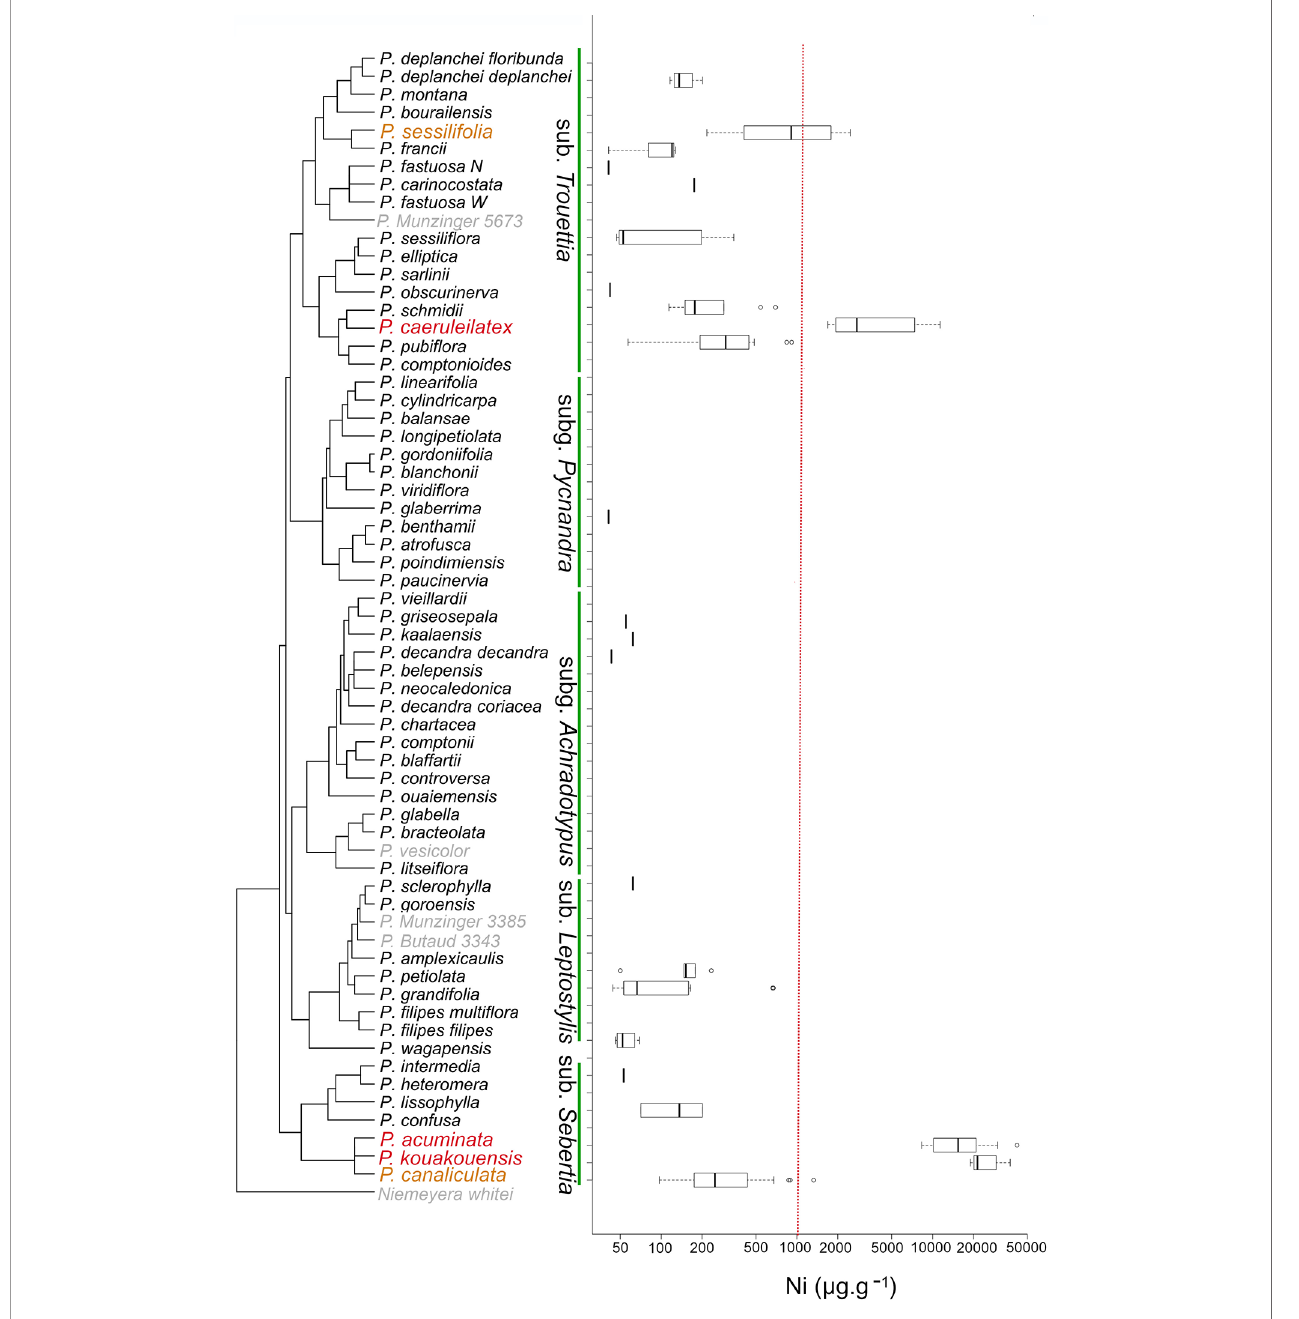
FIGURE 4 | Phylogenetic distribution of hyperaccumulation in the endemic genus Pycnandra (Sapotaceae) from New Caledonia. On the left, phylogenetic tree of Pycnandra , simpli fi ed and adapted from Swenson et al. (Swenson et al., 2007; Swenson et al., 2015), including 57 of the 59 described species, plus 4 undescribed species ( Pycnandra fastuosa W (=open-veined ) , P. Munzinger 3385, P. Butaud 3343, P. Munzinger 5673, see Swenson and Munzinger, 2016 for details). Subgenera are indicated vertically, Niemeyera whitei is kept as outgroup. On the right, boxplot of [Ni] for each species, based on XRF measurements. Species unavailable for XRF measurements are indicate in grey color. The red vertical dash-line indicates the hyperaccumulation threshold ([Ni] >1,000 µg g − 1